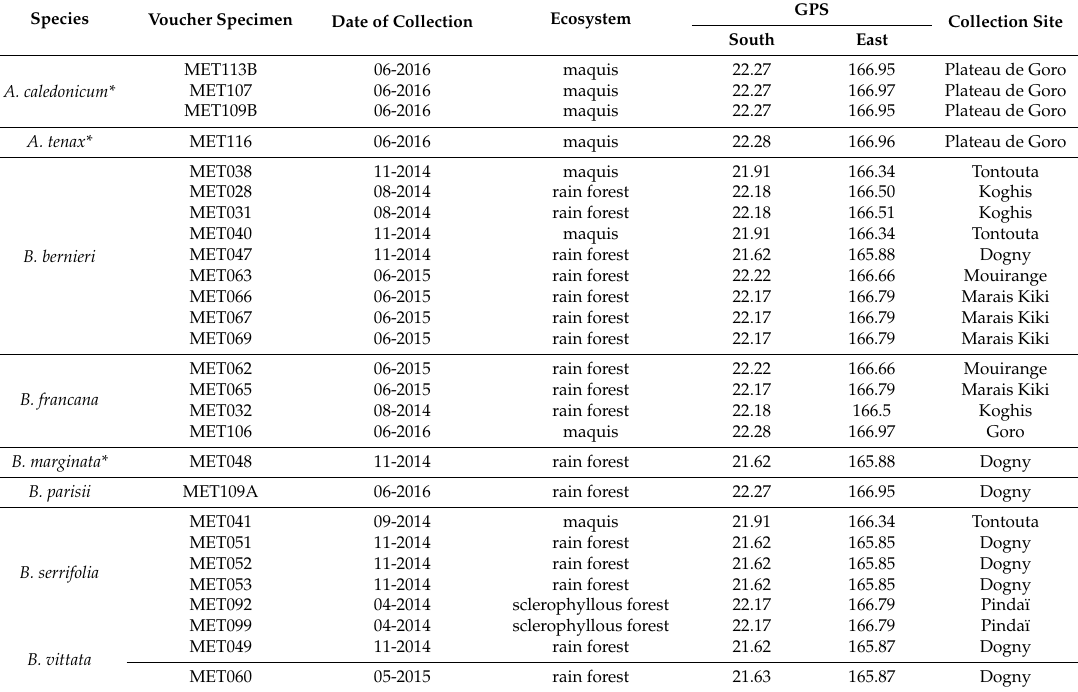
Table 11. Sample collection geodata